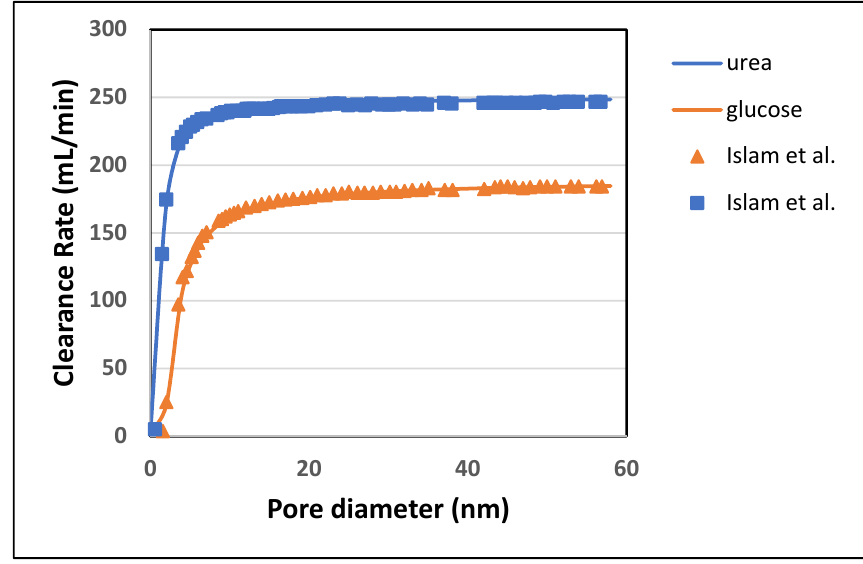
Figure 14. Effect of pore diameter on the clearance rate of urea and glucose.